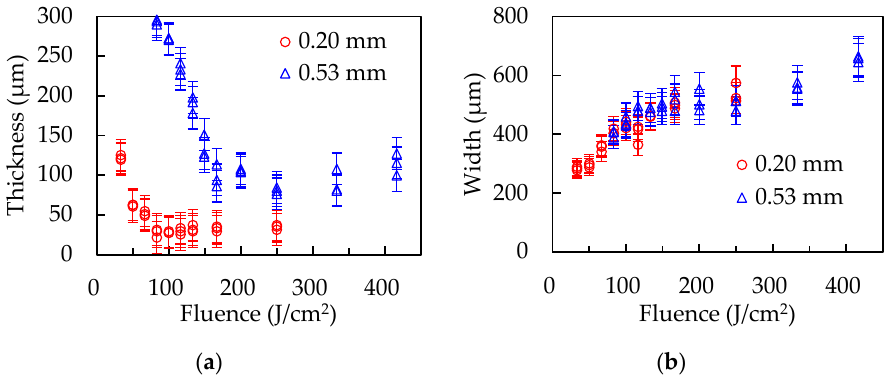
Figure 5. The results of ( a ) film thicknesses and ( b ) groove widths with the PET sheets 0.20 mm and 0.53 mm thick.